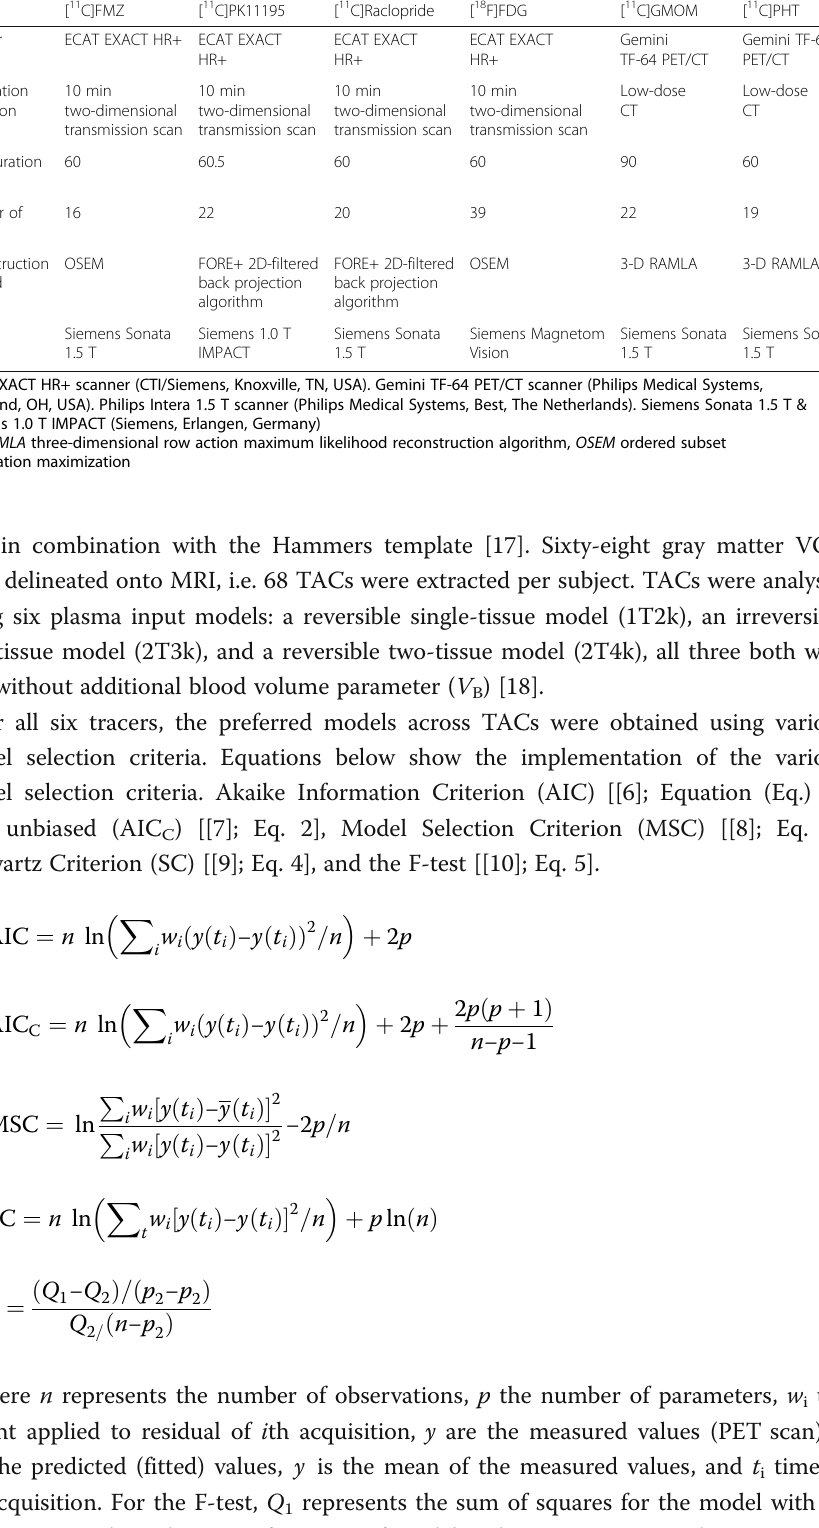
Table 1 Overview of retrospective datasets used